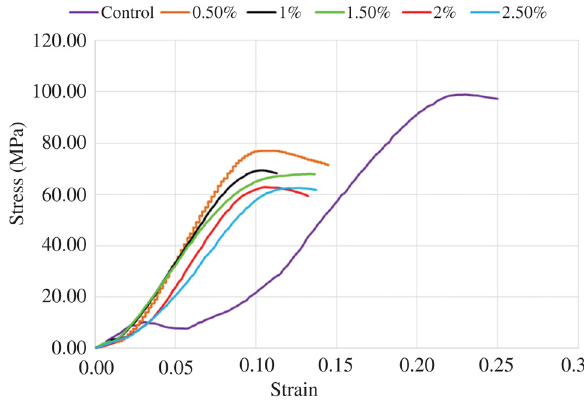
Figure 20: Stress-strain behavior of various compositions of CFR composite.